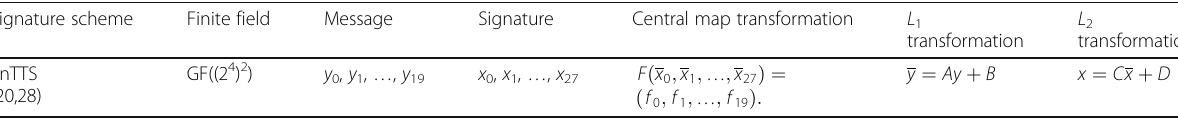
Table 1 Multivariate scheme parameters Signature